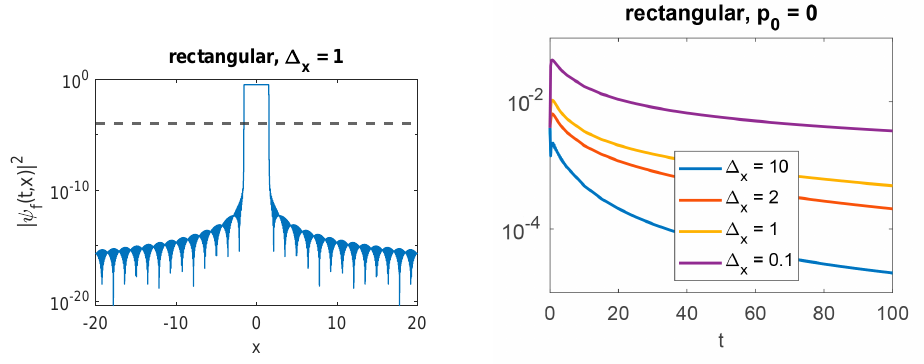
Figure 5. Same as Figure 4 but for an initial rectangle distribution, f ( x ) = 1.